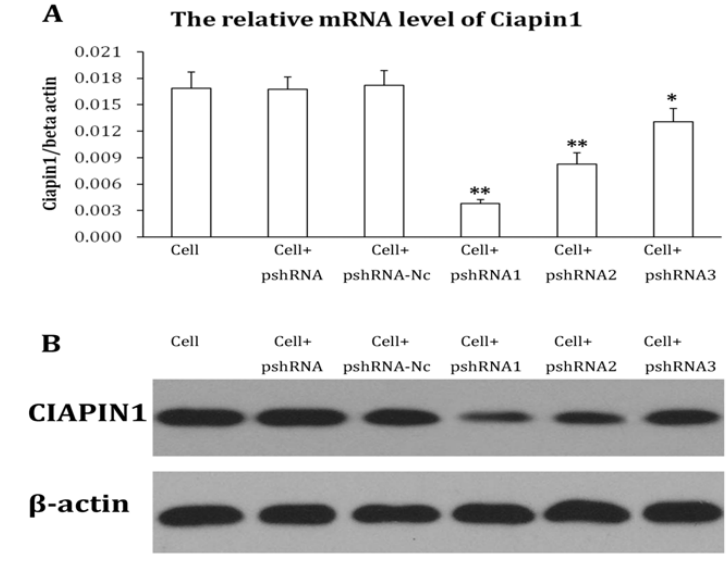
Figure 3. Expression of CIAPIN1 mRNA and protein in each cell line after transfection. Among three siRNAs targeting CIAPIN1, CIAPIN1mRNA and protein expression are most low in CIAPIN1-siRNA1 which is the best interference siRNA